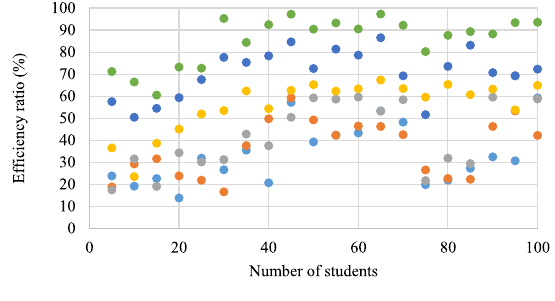
Fig. 11 The analysis of the optimization algorithm in the context of AI and edge computing-based classroom teaching